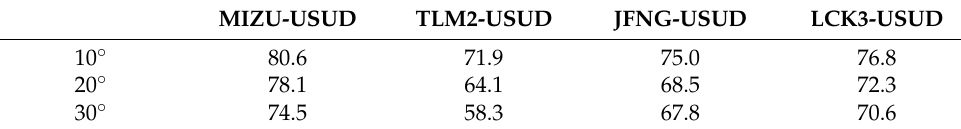
Figure 18. STDs of difference between B2b-RTPPP and GBM-PPP solutions.